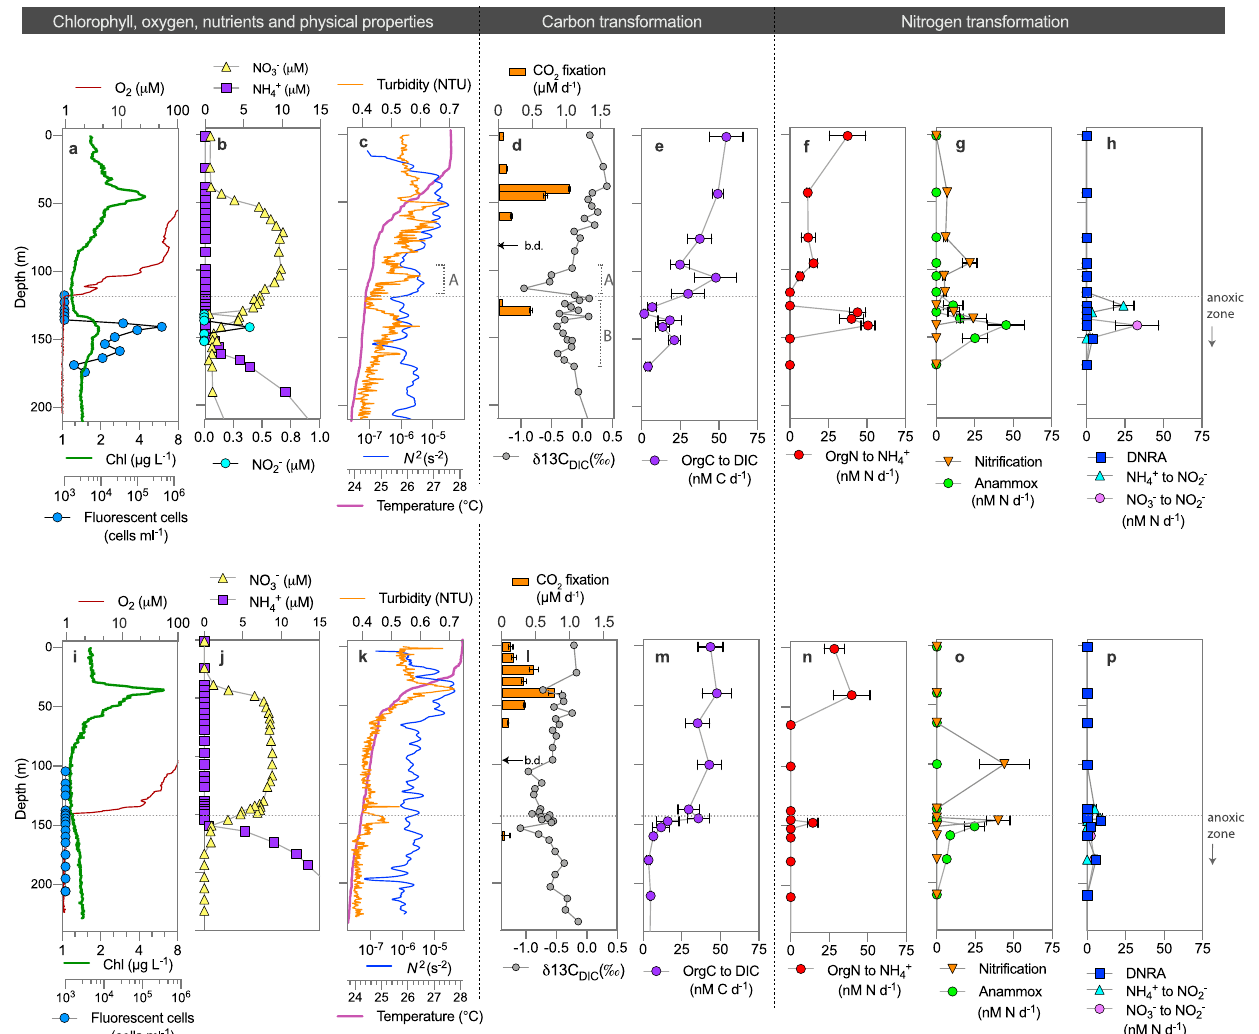
Fig. 2 Nutrient chemistry and the vertical distribution of carbon and nitrogen transformation processes in Lake Tanganyika. The data shown is from the April – May 2019 expedition. Stations 2 and 7 are indicated in the top ( a – h ) and bottom ( i – p ) panels, respectively. The oxygen-de fi cient zone is delimited at an O 2 cutoff of 1 μ M indicated by the dotted line. Note that the x -axes related to oxygen and chlorophyll pro fi les are not shown on linear scales. The bracketed lines in panels c and d indicate peaks A and B discussed in the text. Error bars on carbon fi xation rates, panels d and l , represent the standard deviation; while error bars on panels e – h and m – p represent the standard error (see “ Methods ” ). Abbreviations are as follows: b.d. below detection limits, DNRA dissimilatory nitrate reduction to ammonium, DIC dissolved inorganic carbon (i.e., CO 2